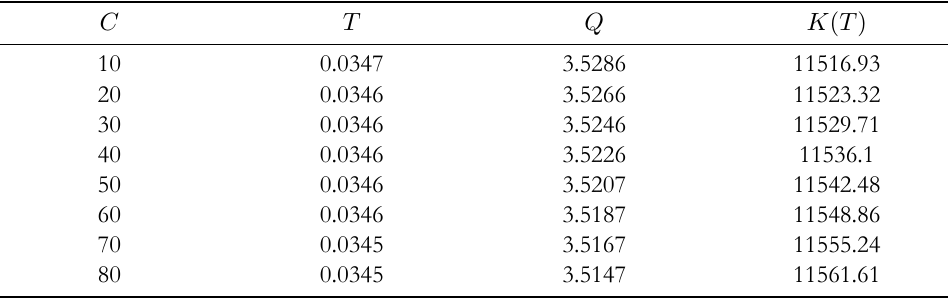
Table 9: Variation in T , Q & K ( T ) with purchasing cost ( C